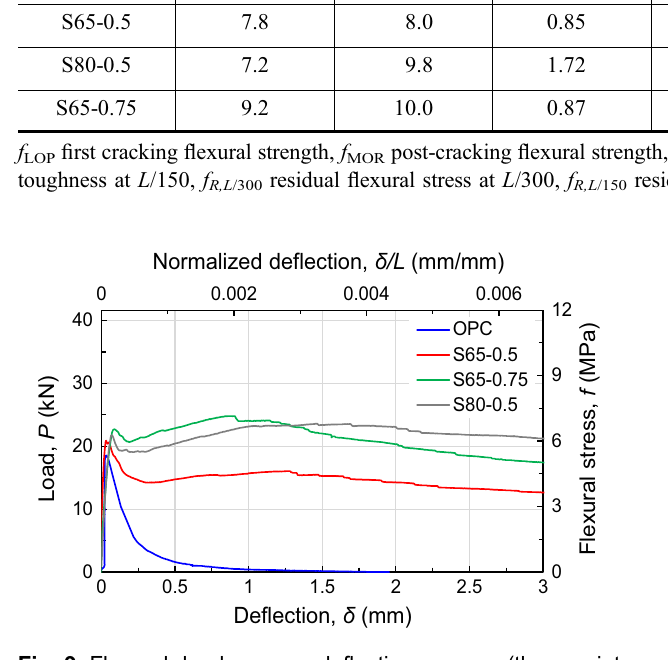
Fig. 9 Flexural load versus deflection curves (three-point flexure).